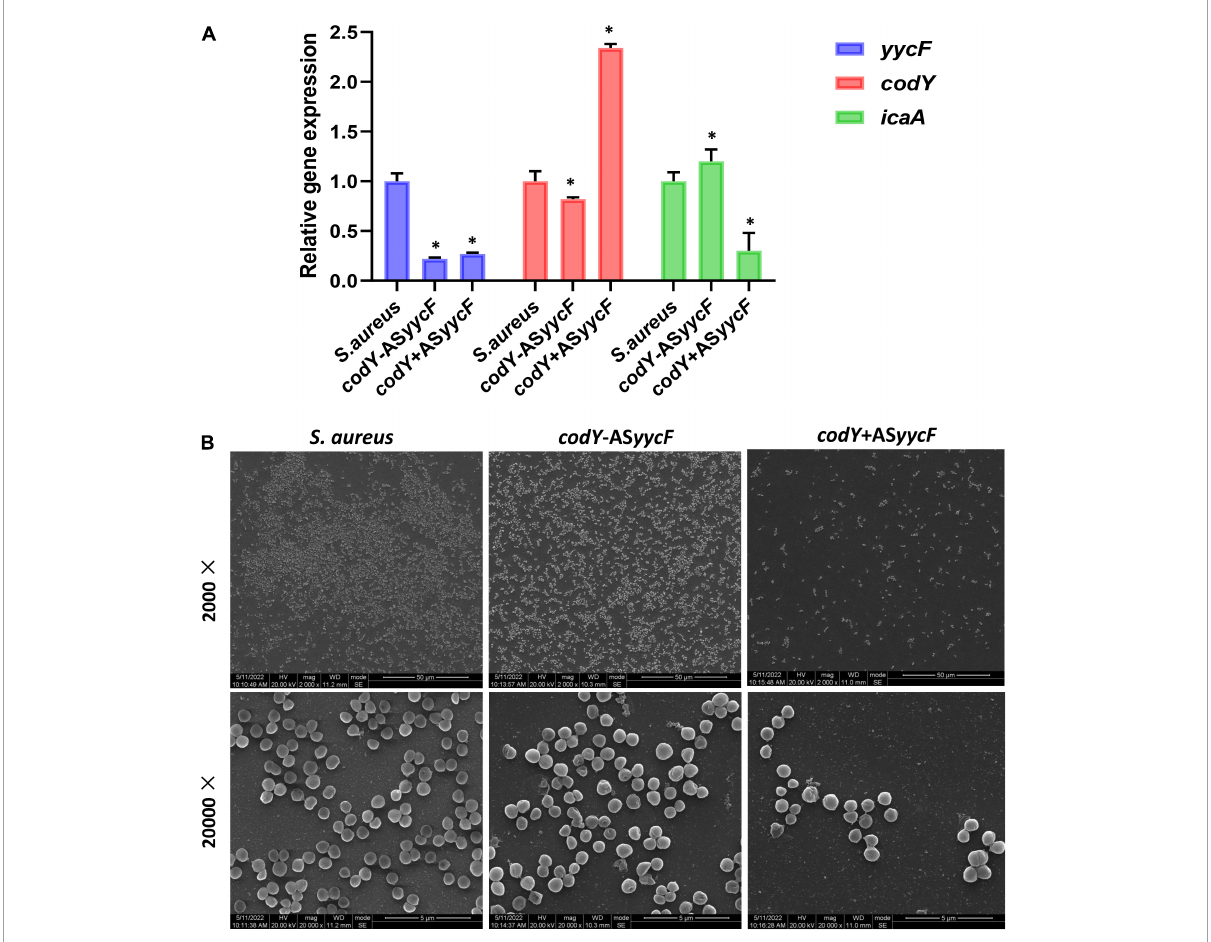
FIGURE2 CodY interaction with yycF affects biofilm morphology. (A) Quantitative RT-PCR analysis showed the gene expressions in S. aureus , codY + AS yycF, and codY -AS yycF dual- mutant stains. S. aureus gene expression was relatively quantified by RT-PCR using 16S as an internal control ( n = 5, * P < 0.05). (B) SEM images of S. aureus , codY + AS yycF, and codY -AS yycF dual- mutant